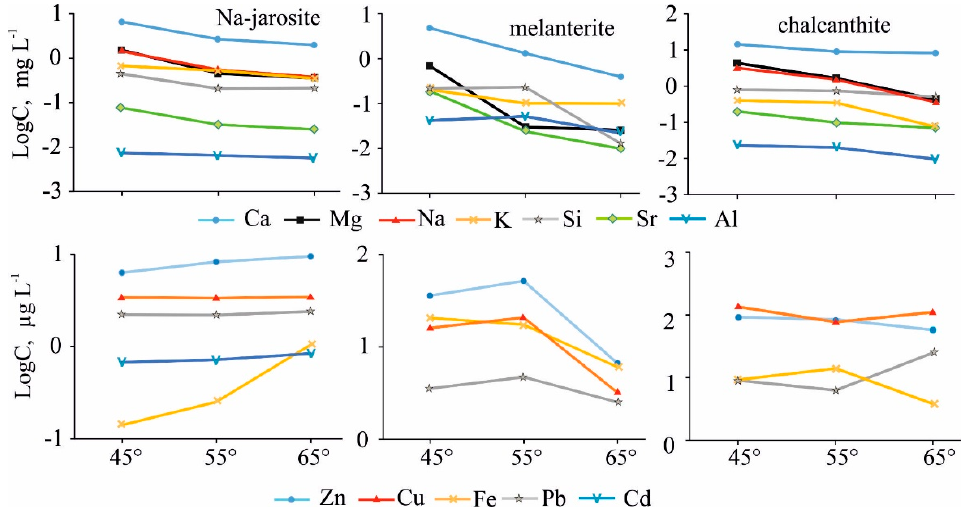
Figure 9. Dynamics of element migration with the vapor-gas phase, at di ff erent temperatures, from the three main minerals studied.